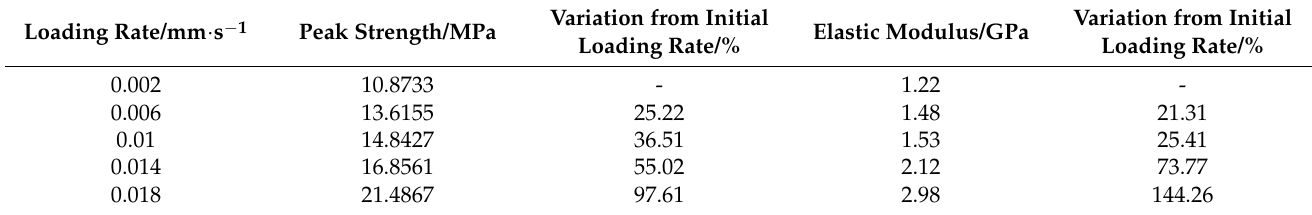
Table 1. Mechanical parameters of coal samples under different loading